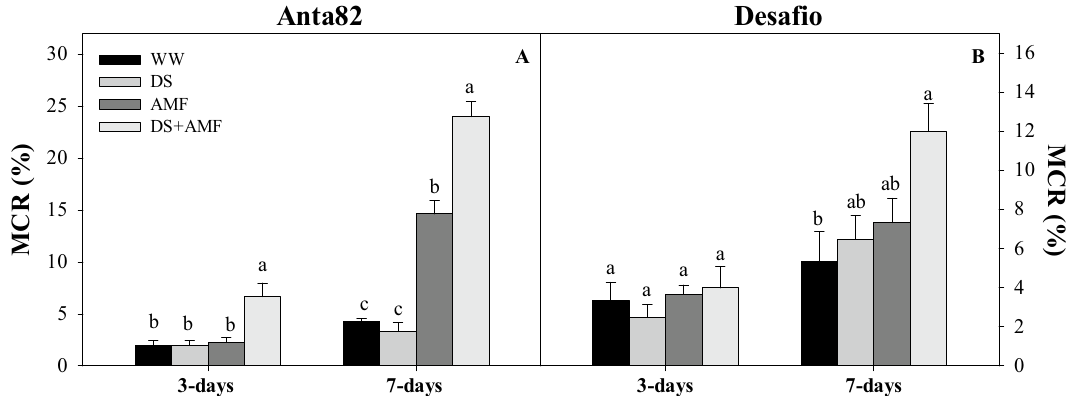
Figure 1. Mycorrhizal colonization (MCR) on days 3 and 7 in the ( A ) Anta82 and ( B ) Desafio soybean cultivars under different conditions of inoculation and water stress. WW = well-watered, noninoculated, DS = drought stress, noninoculated, WW + AMF = well-watered and inoculated, DS + AMF = drought stress and inoculated. The bars represent the mean ± SEM ( n = 4). Pairs of means in the same period (3 or 7 days) with different letters are significantly different ( p < 0.05), based on Tukey’s post hoc